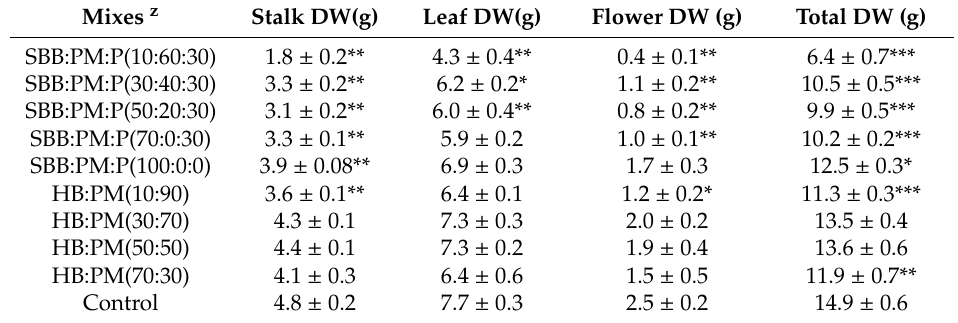
Note: z SBB = sugarcane bagasse biochar; HB = mixed hardwood biochar; P = perlite; PM = peat moss; Control = commercial growing substrate. Numbers in parentheses indicate the ratio of di ff erent components, by